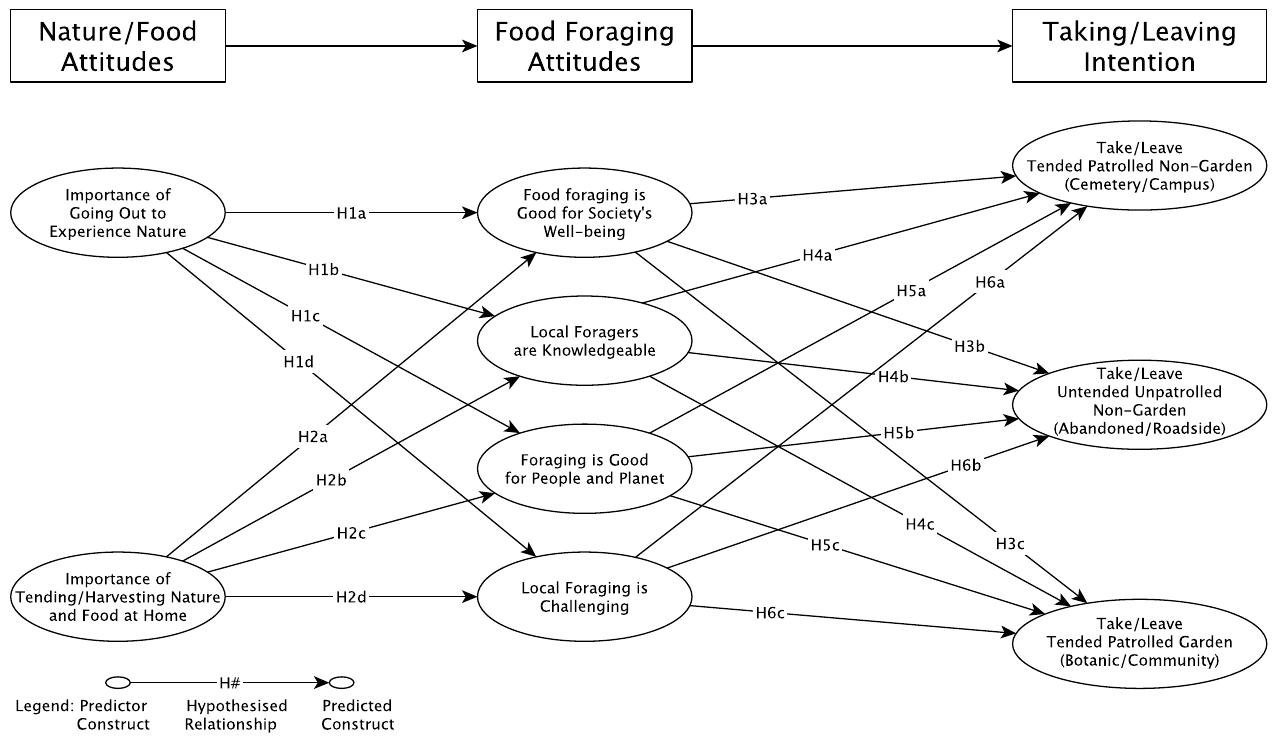
Figure 1. Conceptual Model of Food Foraging Behavior (Taking/Leaving).